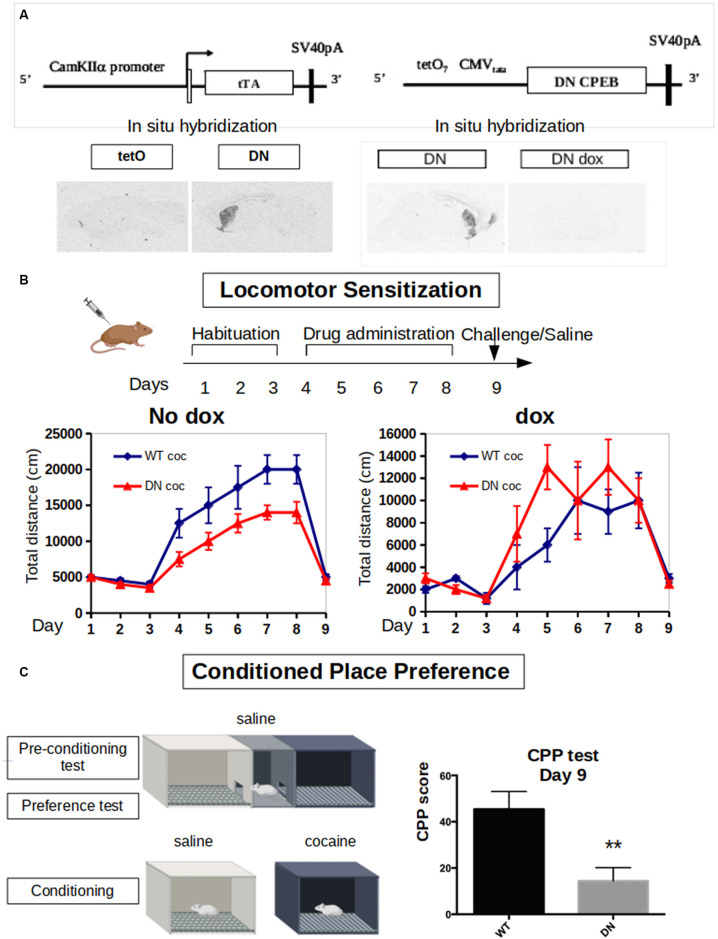
Dominant-negative DN-CPEB mice exhibit a deficit in both locomotor sensitization and Conditioned Place Preference (CPP) after cocaine treatment. (A) Schematic of the tetO and tTA transgenes of the DN-CPEB mice. In situ hybridization shows the expression of the transgene in the absence of doxycycline. (B) DN-CPEB mice were tested in a locomotor sensitization behavioral task. After 3 days of habituation in which both DN-CPEB and wild type (WT) mice, 10 per group, were shown to have similar baseline locomotion, mice were injected with cocaine 30 mg/kg for five consecutive days and their movement was recorded. DN-CPEB mice showed a considerable decrease in motor sensitization when compared to WT mice (F = 18.137; ANOVA, p < 0.0001). As control-CPEB mice were exposed to doxycycline (200 mg/kg) to prevent the expression of the TetO transgene. After 3 days of habituation in which both DN-CPEB dox and WT mice, 10 per group, were shown to have similar baseline locomotion, mice were injected with cocaine 30 mg/kg for five consecutive days and their movement was recorded. DN-CPEBdox mice showed no decrease in motor sensitization when compared to WT mice. (C) CPP was performed with the DN-CPEB and WT mice. After 4 days of cocaine pairing for both the DN-CPEB and WT animals, on the test day, the DN-CPEB mice spent less time in the cocaine-paired box compared to the WT mice (two-tailed t-test, p = 0.004), suggesting a potential role of CPEB1 and 3 in the rewarding properties of cocaine. **p < 0.01.